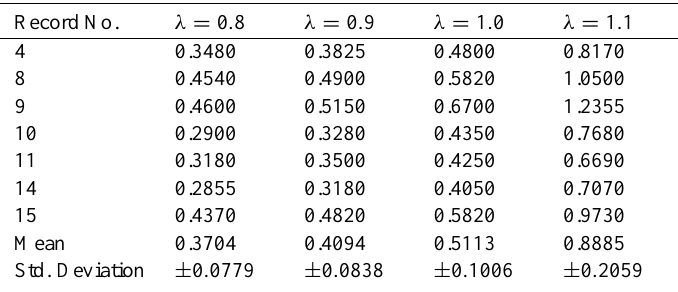
Table 4. Adapted γ values from AUSWEX